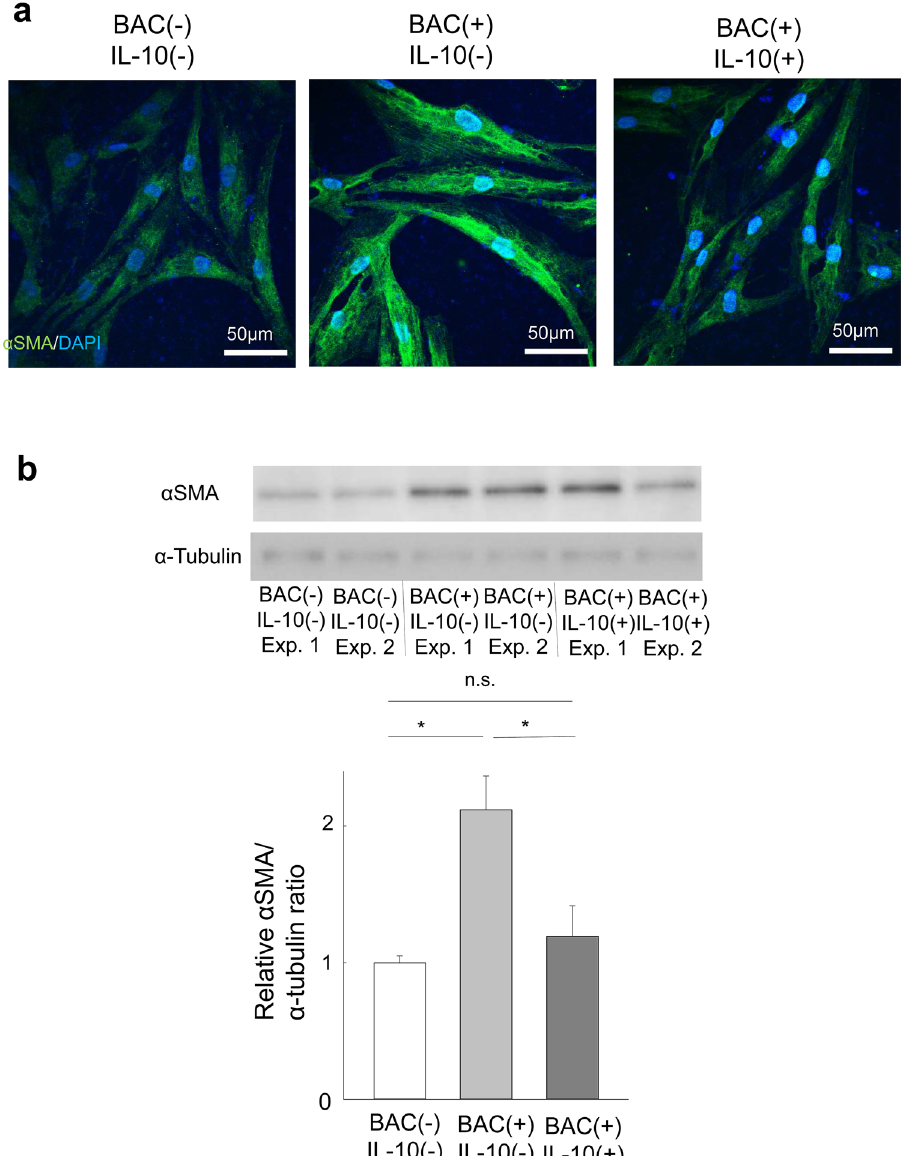
Figure 5. Effect of IL-10 on the BAC-induced transdifferentiation of HTFs into myofibroblasts. ( a ) HTFs were incubated first with or without IL-10 (300 pg/ml) for 24 h and then in the additional absence or presence of BAC (5 × 10 −6 %) for 24 h, after which the cells were subjected to immunofluorescence staining with antibodies to αSMA (green). Nuclei were counterstained with DAPI (blue). Scale bars, 50 µm. ( b ) Cells treated as in ( a ) were subjected to immunoblot analysis with antibodies to αSMA. Blots for two independent experiments as well as quantitative data (means + s.e.m.) for the relative αSMA/α-tubulin band intensity ratio from five independent experiments are shown. * p < 0.05, n.s. (Holm-Sidak post hoc test). Full-length blots are presented in Supplementary Fig.